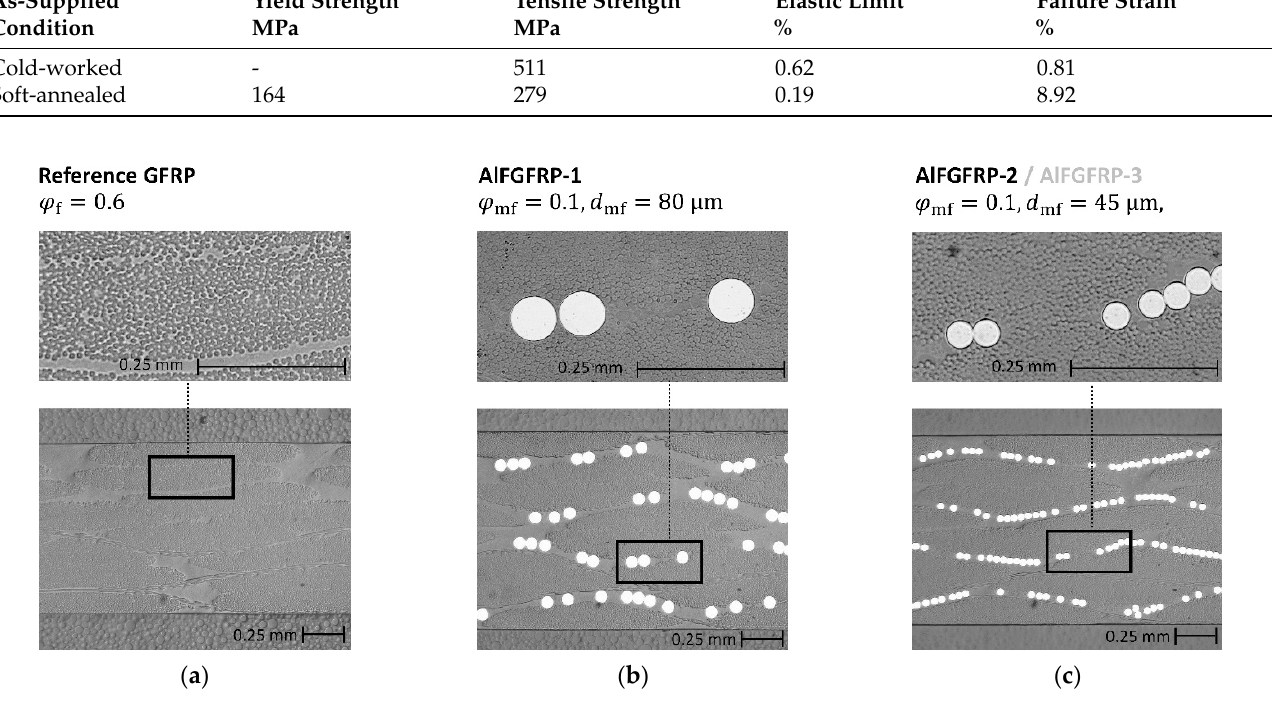
Figure 6. Overview of the three manufactured laminated configurations: ( a ) reference GFRP; ( b ) AlGFRP-1, containing work-hardened wire; ( c ) AlFGFRP-2 (work-hardened) and, equivalently, AlFGFRP-3 (soft-annealed).